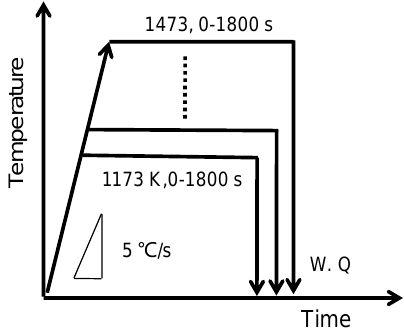
Figure 1. Schematic illustrations of the annealing treatment.